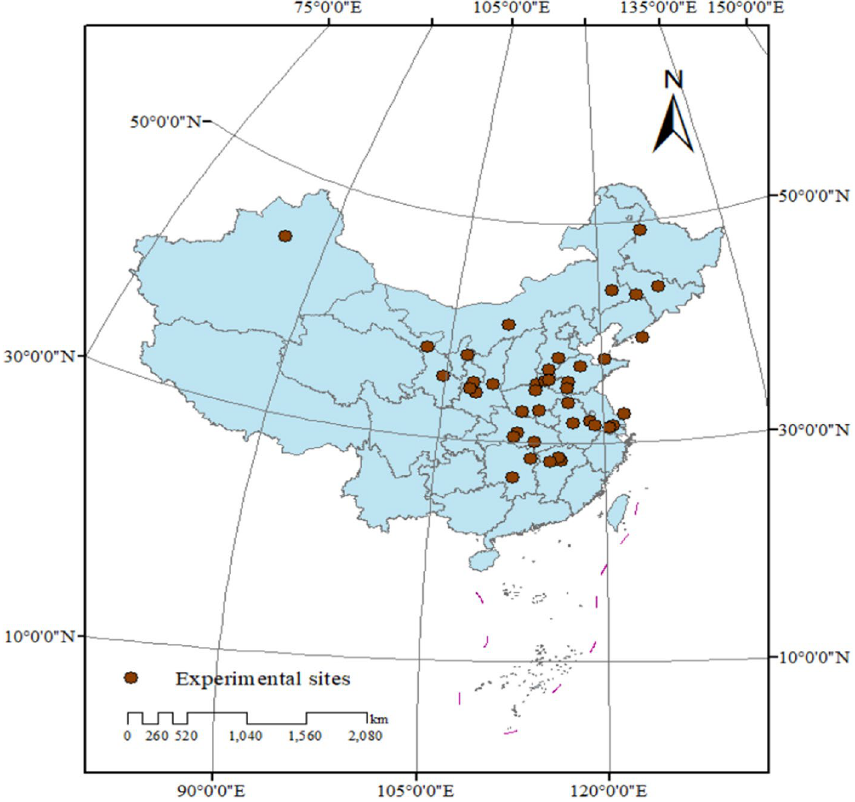
Figure 6. Spatial distribution map of chemical nitrogen fertilizers field experiment sites in